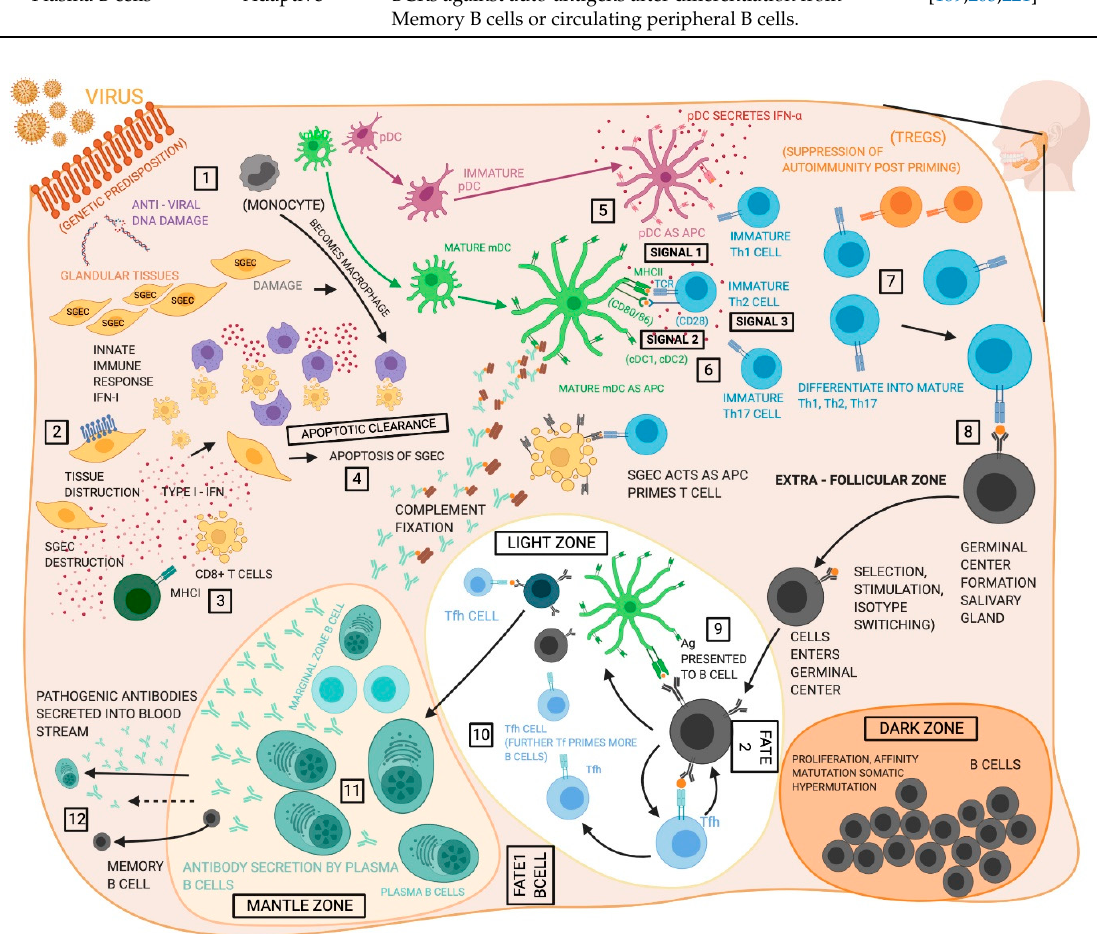
Figure 1. Proposed functions of different cell types in the pathogenesis of Sjögren’s syndrome (SS). (1) The initiating events in the development of SS remain unclear, but evidence suggests the disease proceeds following an environmental trigger on a susceptible genetic background, likely a viral infection. (2) Salivary gland epithelia cells (SGECs) experience increased apoptosis and act as sources of inflammatory cytokines and chemokines within the salivary gland (SG). (3) CD8 + T cells are poorly understood in SS, but may contribute to tissue destruction in the glands. (4) Macrophages participate in tissue destruction through the release of proteases and cytokines and display reduced efferocytosis allowing unremoved apoptotic cells to act as sources of self ‐ antigen. (5) Type I interferon (T1 ‐ IFN) both initiates antiviral activity and exerts an activating effect on cells of the immune system. T1 ‐ IFN is produced by multiple cell types but is closely associated with plasmacytoid DCs (pDCs). (6) Myeloid dendritic cells (mDCs) are the dominant antigen presenting cells to T cells, however,